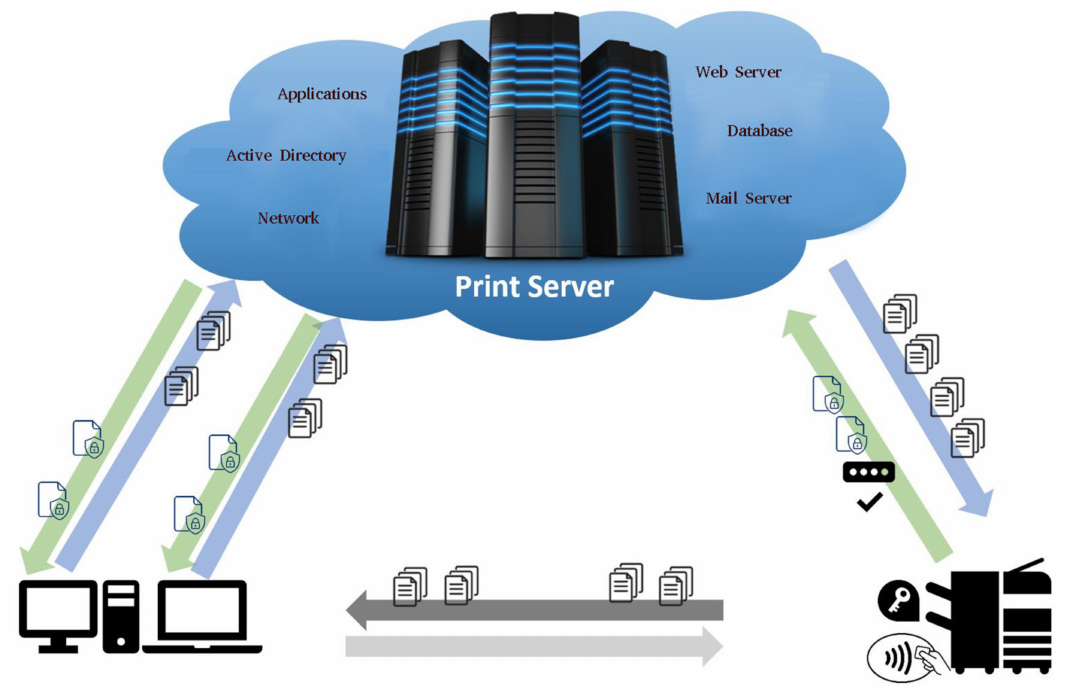
Figure 9. Final solution model to easily view the printing process. Source: custom